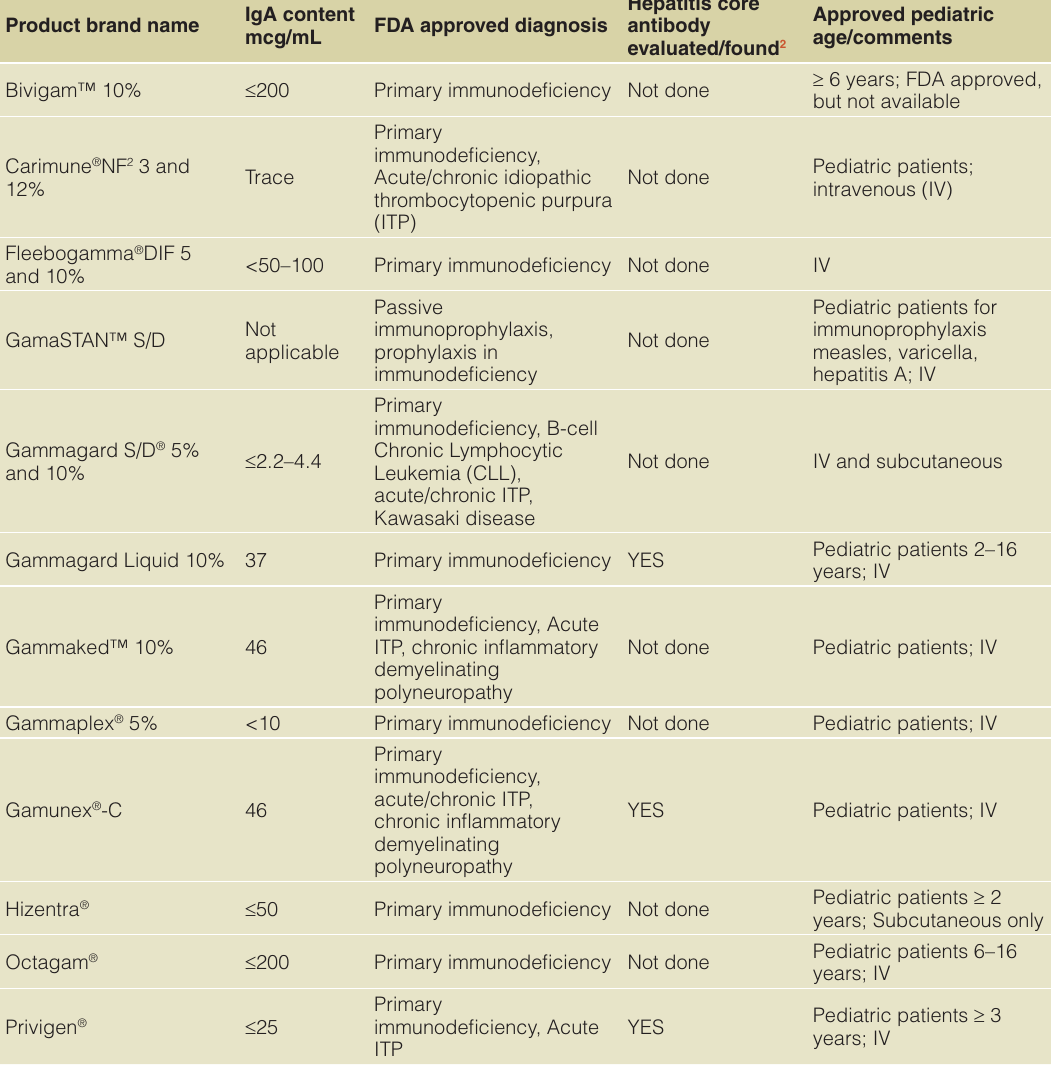
Table 3. Immune globulin products available in the